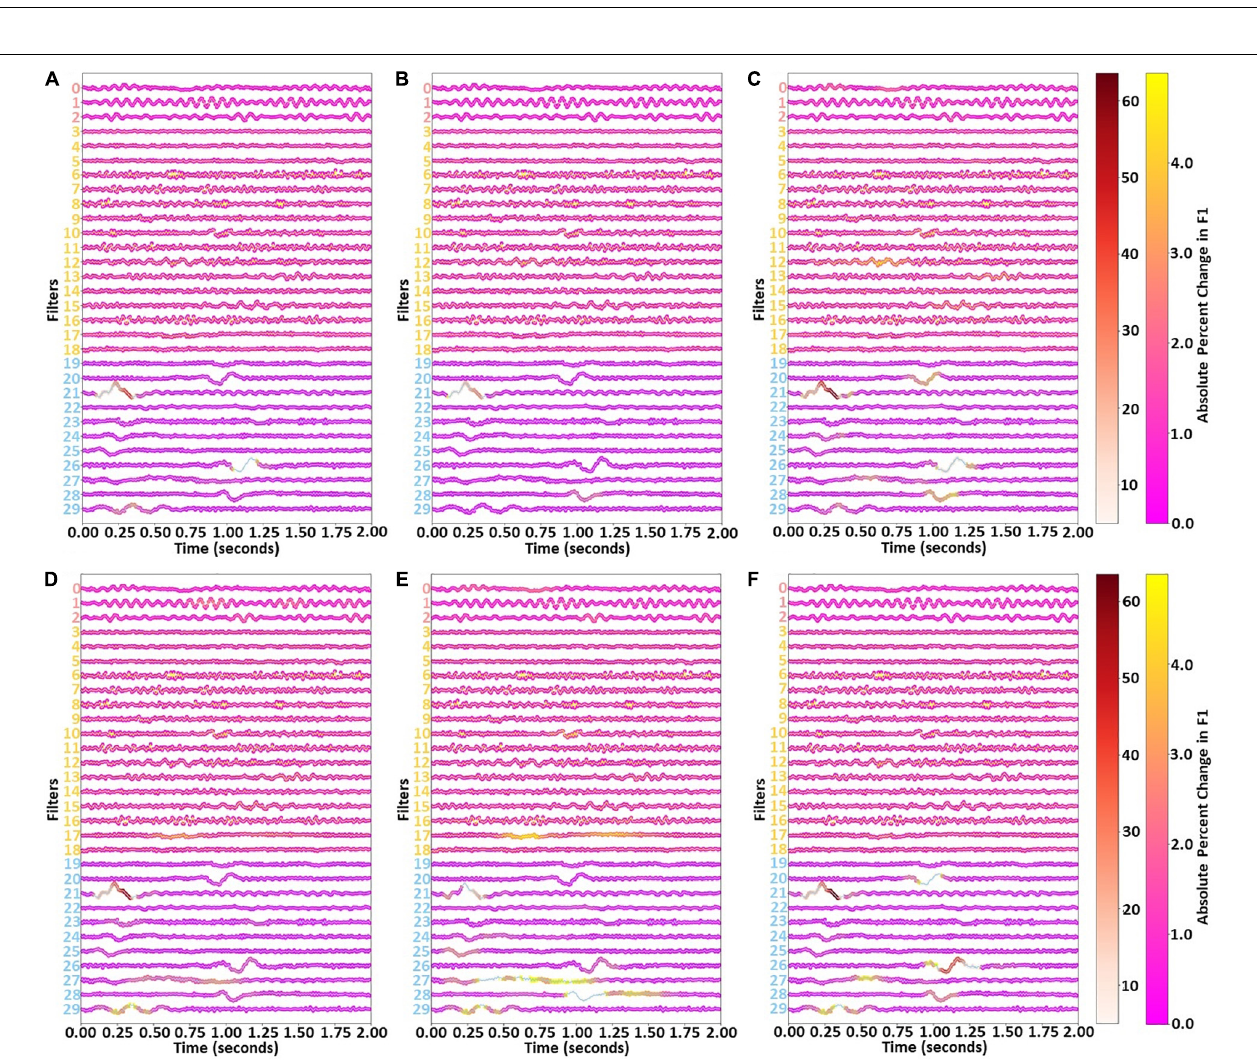
FIGURE 5 | Effect of cluster-level spectral perturbation on each class. The leftmost, middle, and rightmost panels show the percent change in class-specific F1-score that resulted from perturbing each frequency band in Clusters 0, 1, and 2, respectively.